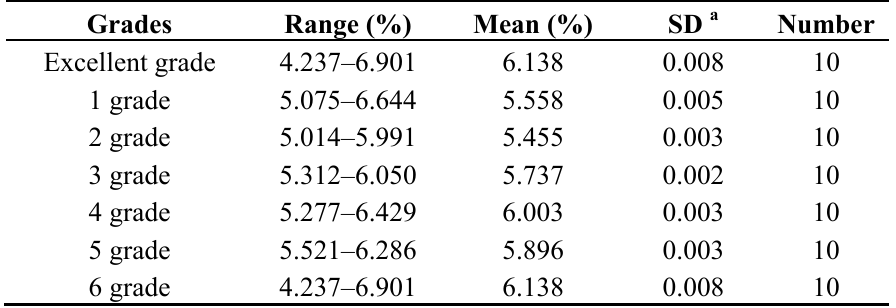
Table 3. Statistical information of moisture content (w.b., %) of samples in type II.